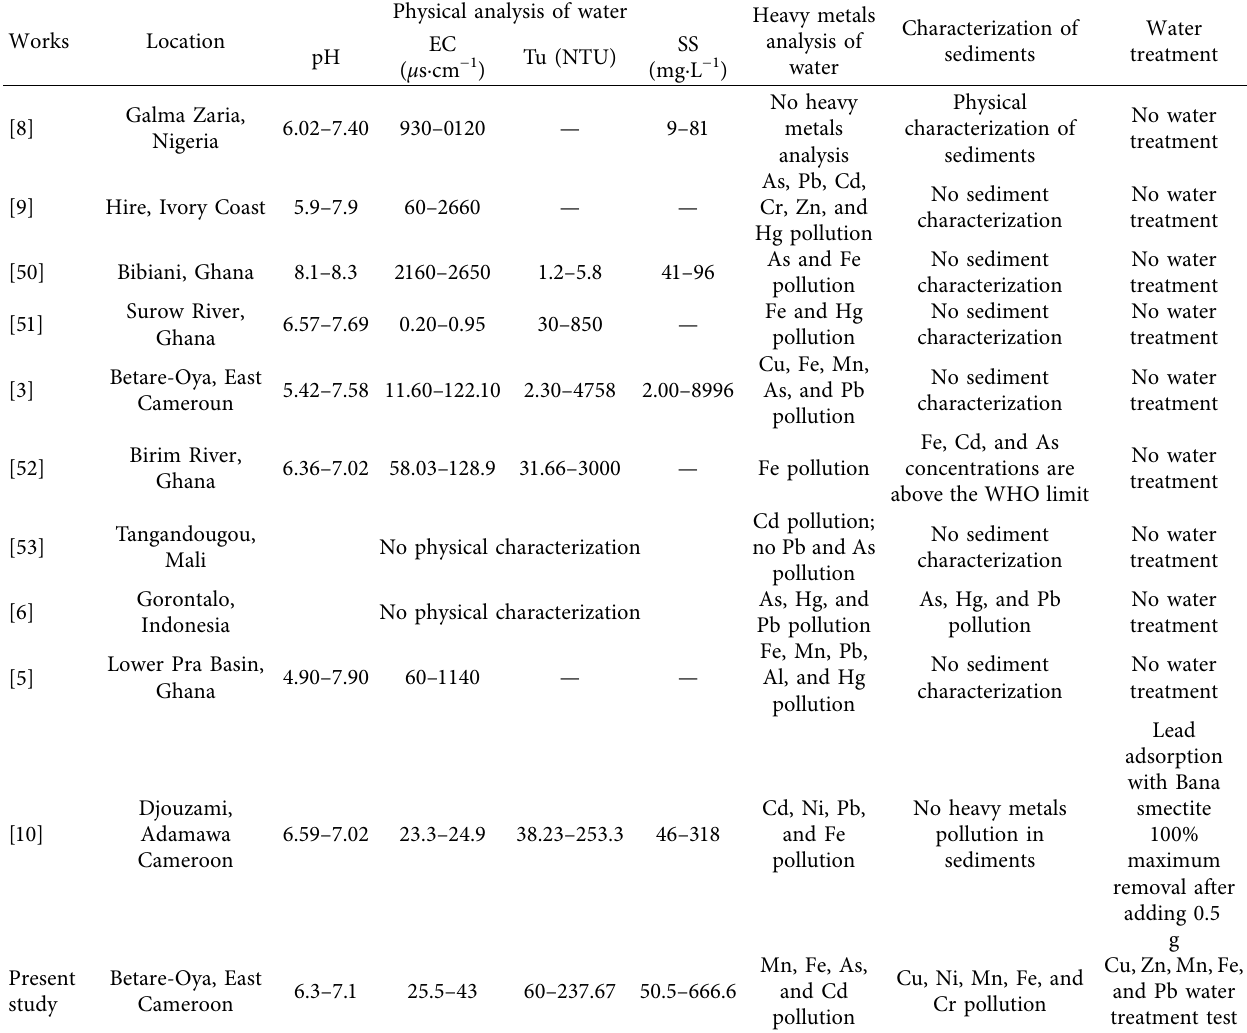
Table 13: Comparison of the results with similar works: same and different